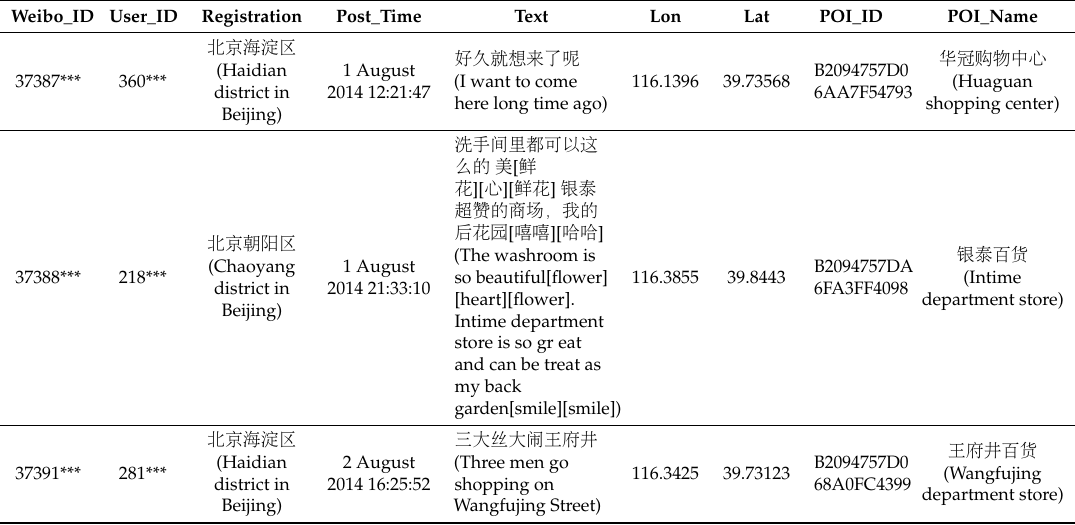
Table 1. Sina Weibo data